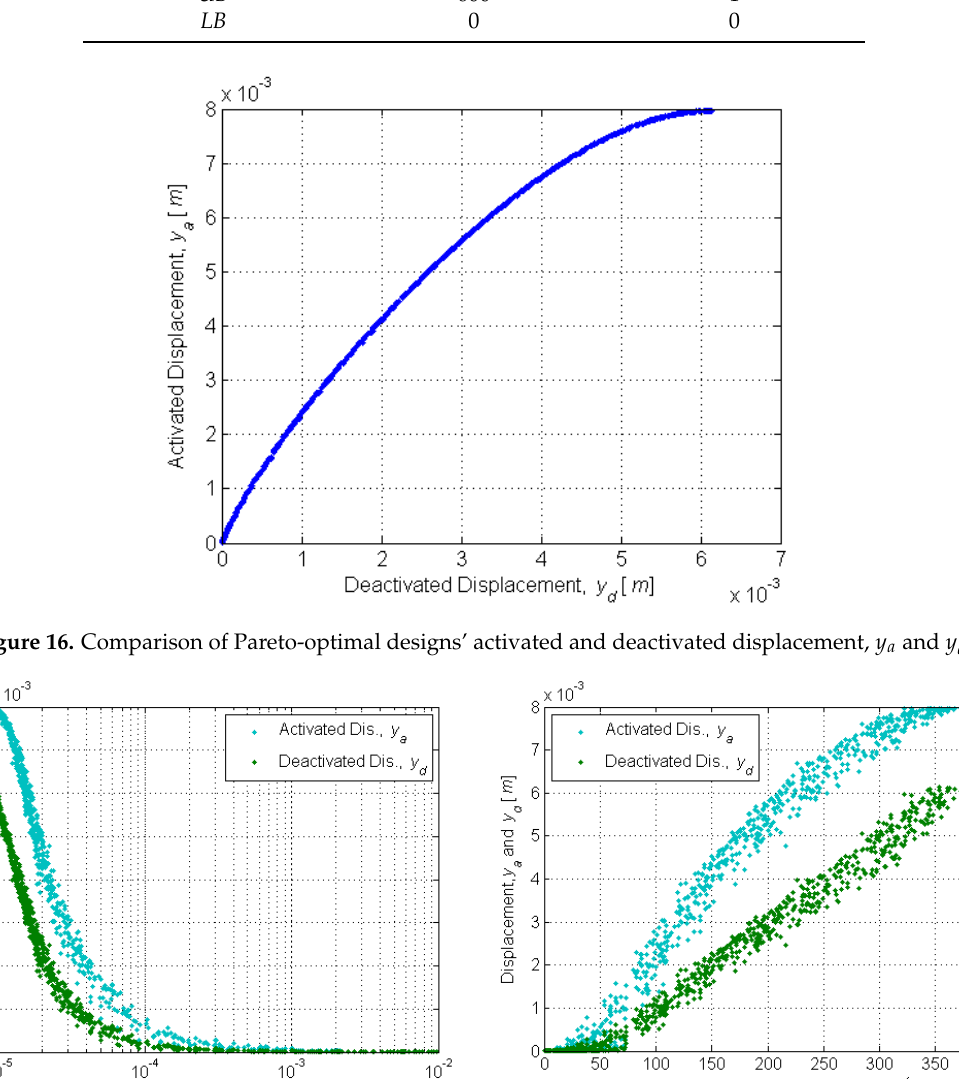
Figure 17. Effects of Pareto-optimal design parameters on activated ( y a ) and deactivated ( y d ) displacement: ( a ) flexural rigidity, EI, ( b ) initial curvature, κ 0